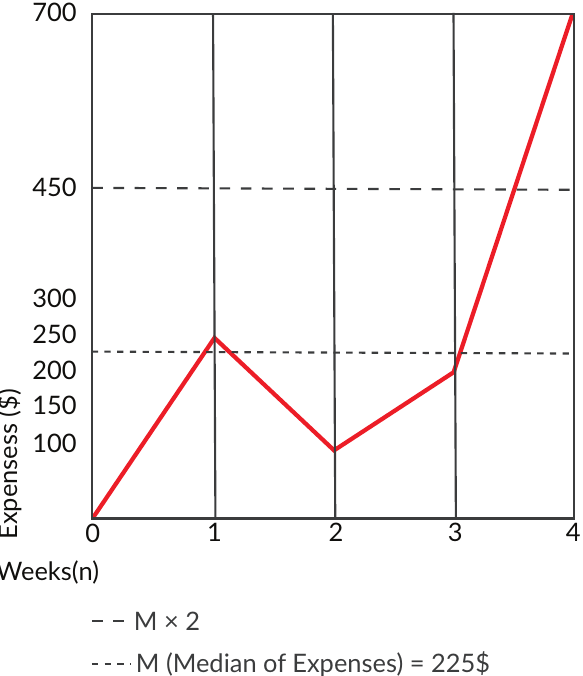
Figure 3. Outlier detection.